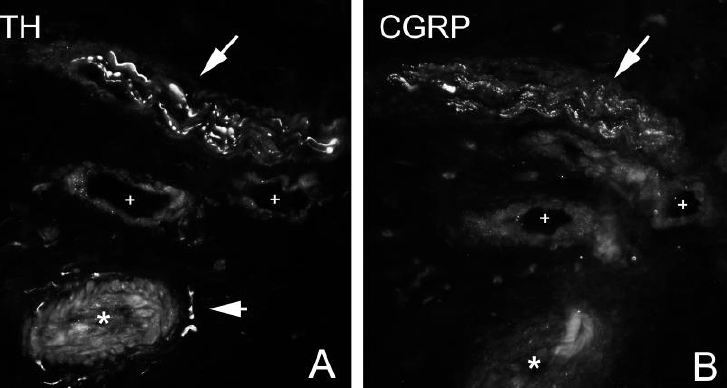
Figure 5. Parallel sections stained for TH ( A ) and CGRP ( B ). The nerve fascicle contains positive immunoreactions both for TH and CGRP (arrows). Perivascular immunoreactions were only seen for TH (arrow head). Asterisks and crosses indicate the position of the same blood vessel.